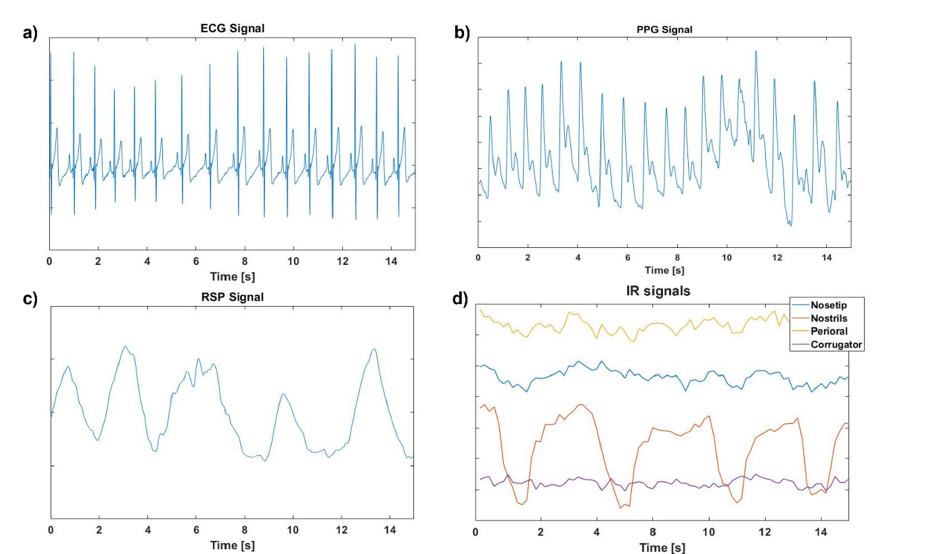
Figure 2. Pre-processed physiological signals trends during the task of a randomly chosen participant. In detail, ( a ) Electrocardiogram, ( b ) Photoplethysmogram, ( c ) Respiration, and ( d ) Thermal infrared signals trends.